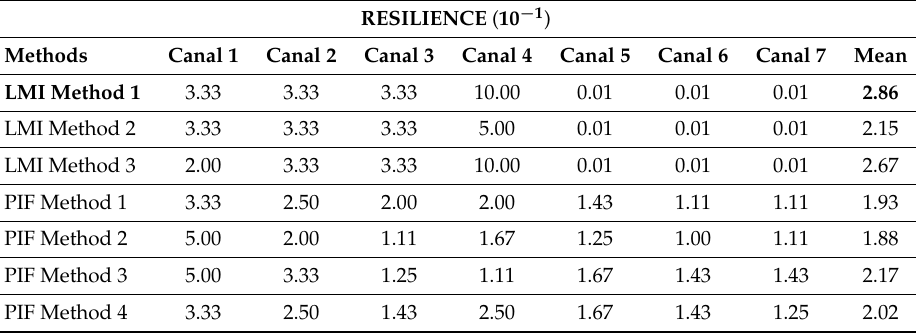
Table 4. Non-linear model simulation KPIs: